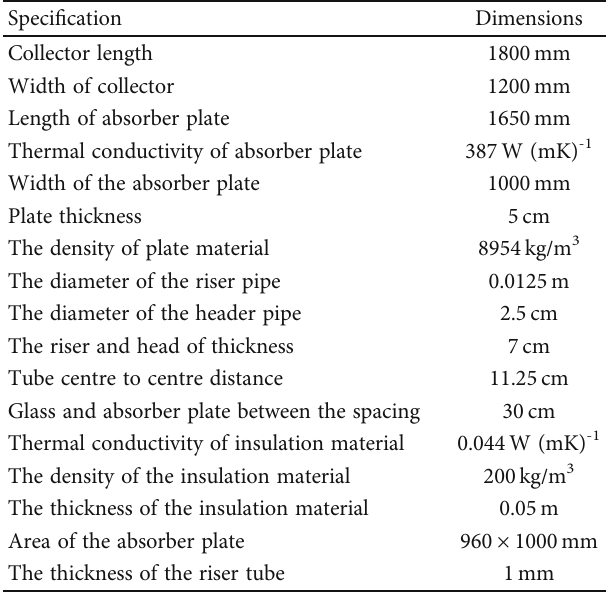
Table 1: Speci fi cation of the experimental setup.